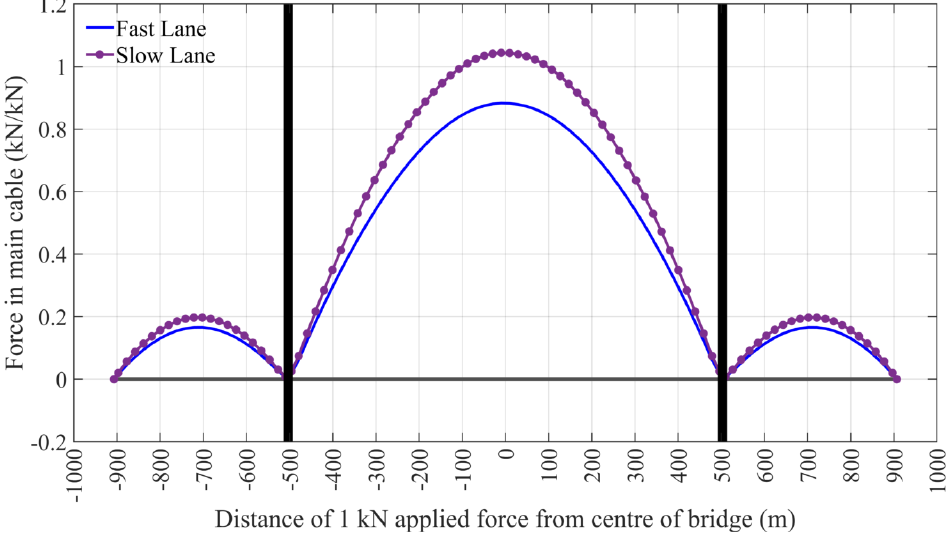
Figure 7. Influence lines for axial force in the main cable on the West side (northbound lanes).